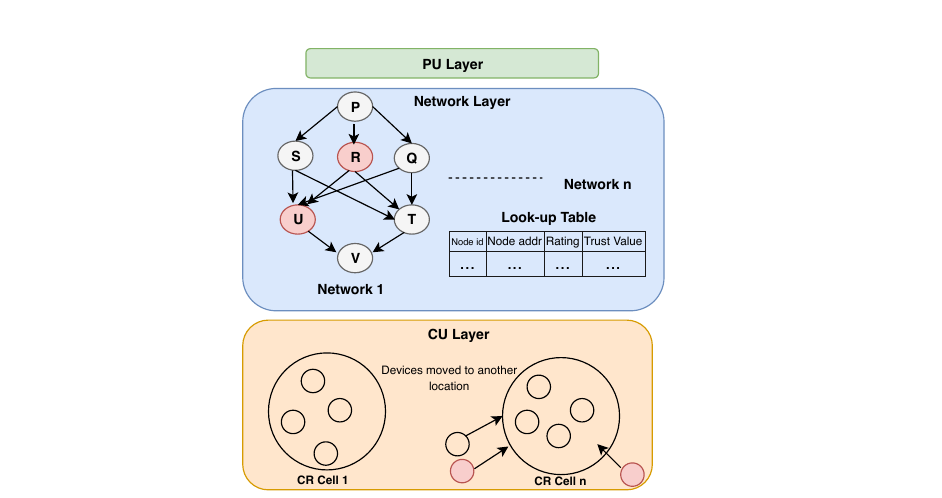
Figure 5. System model of the NN layer. Algorithm 2: Calculation of Activeness().